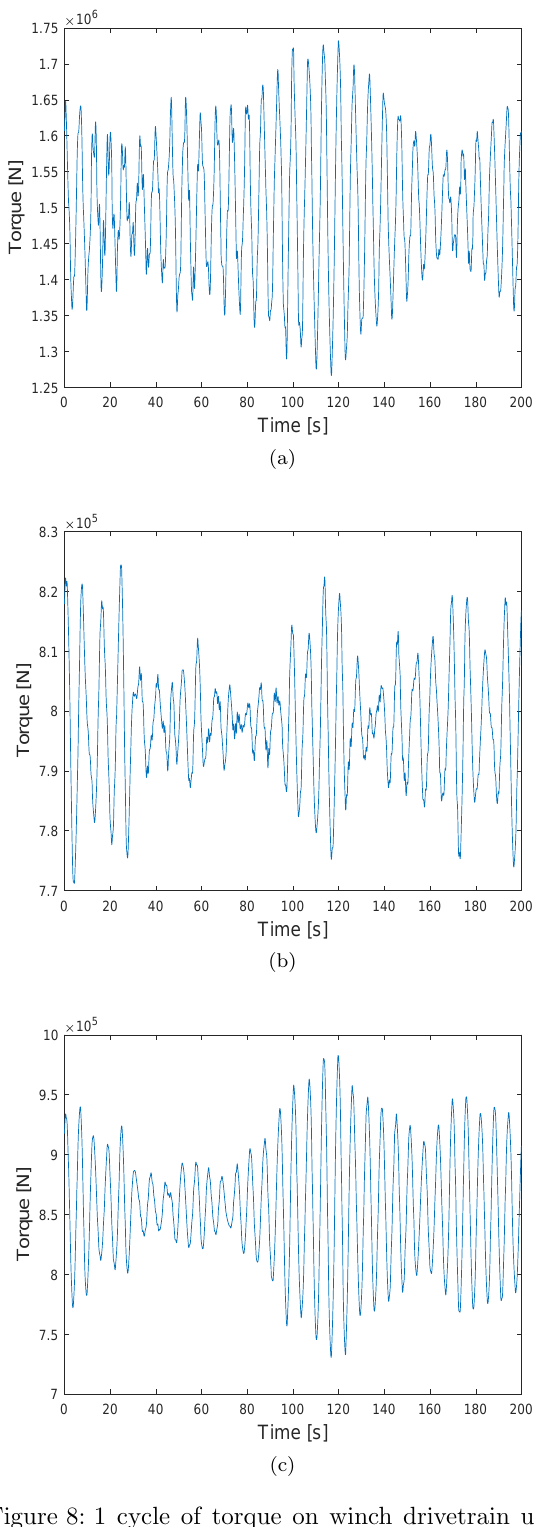
Figure 8: 1 cycle of torque on winch drivetrain using Rope A, B and C from top to bottom re-